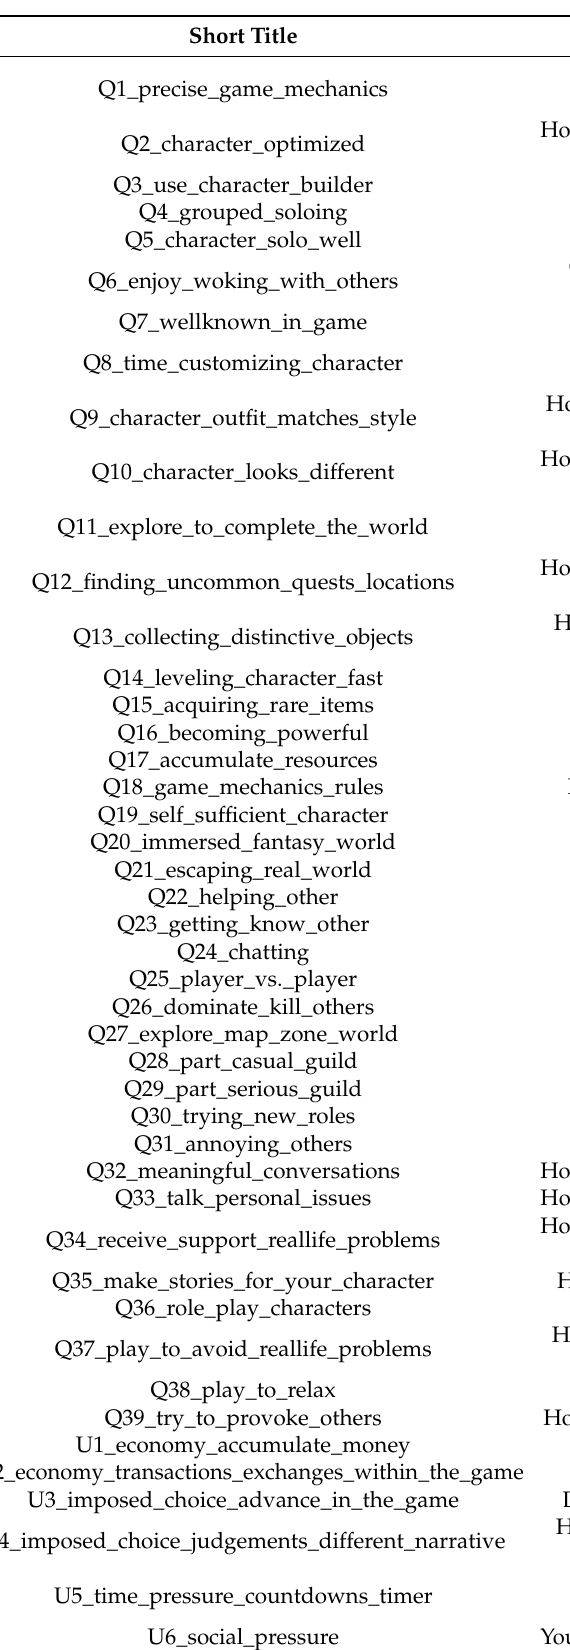
Table 3. Relation of the complete question title to the short term used in the